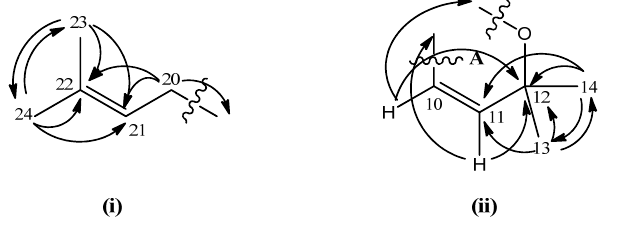
Figure 2. Prenyl moiety (i) and pyrano ring system (ii) and their HMBC